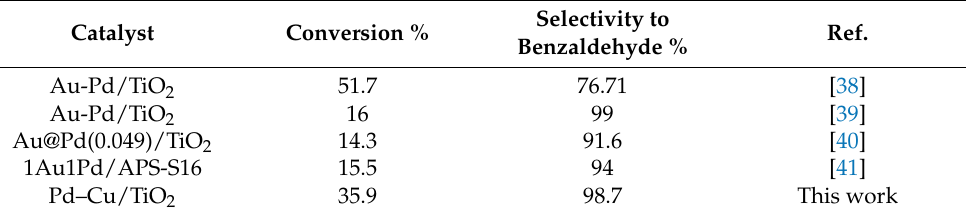
Table 4. Comparison of the benzyl alcohol oxidation activity over different